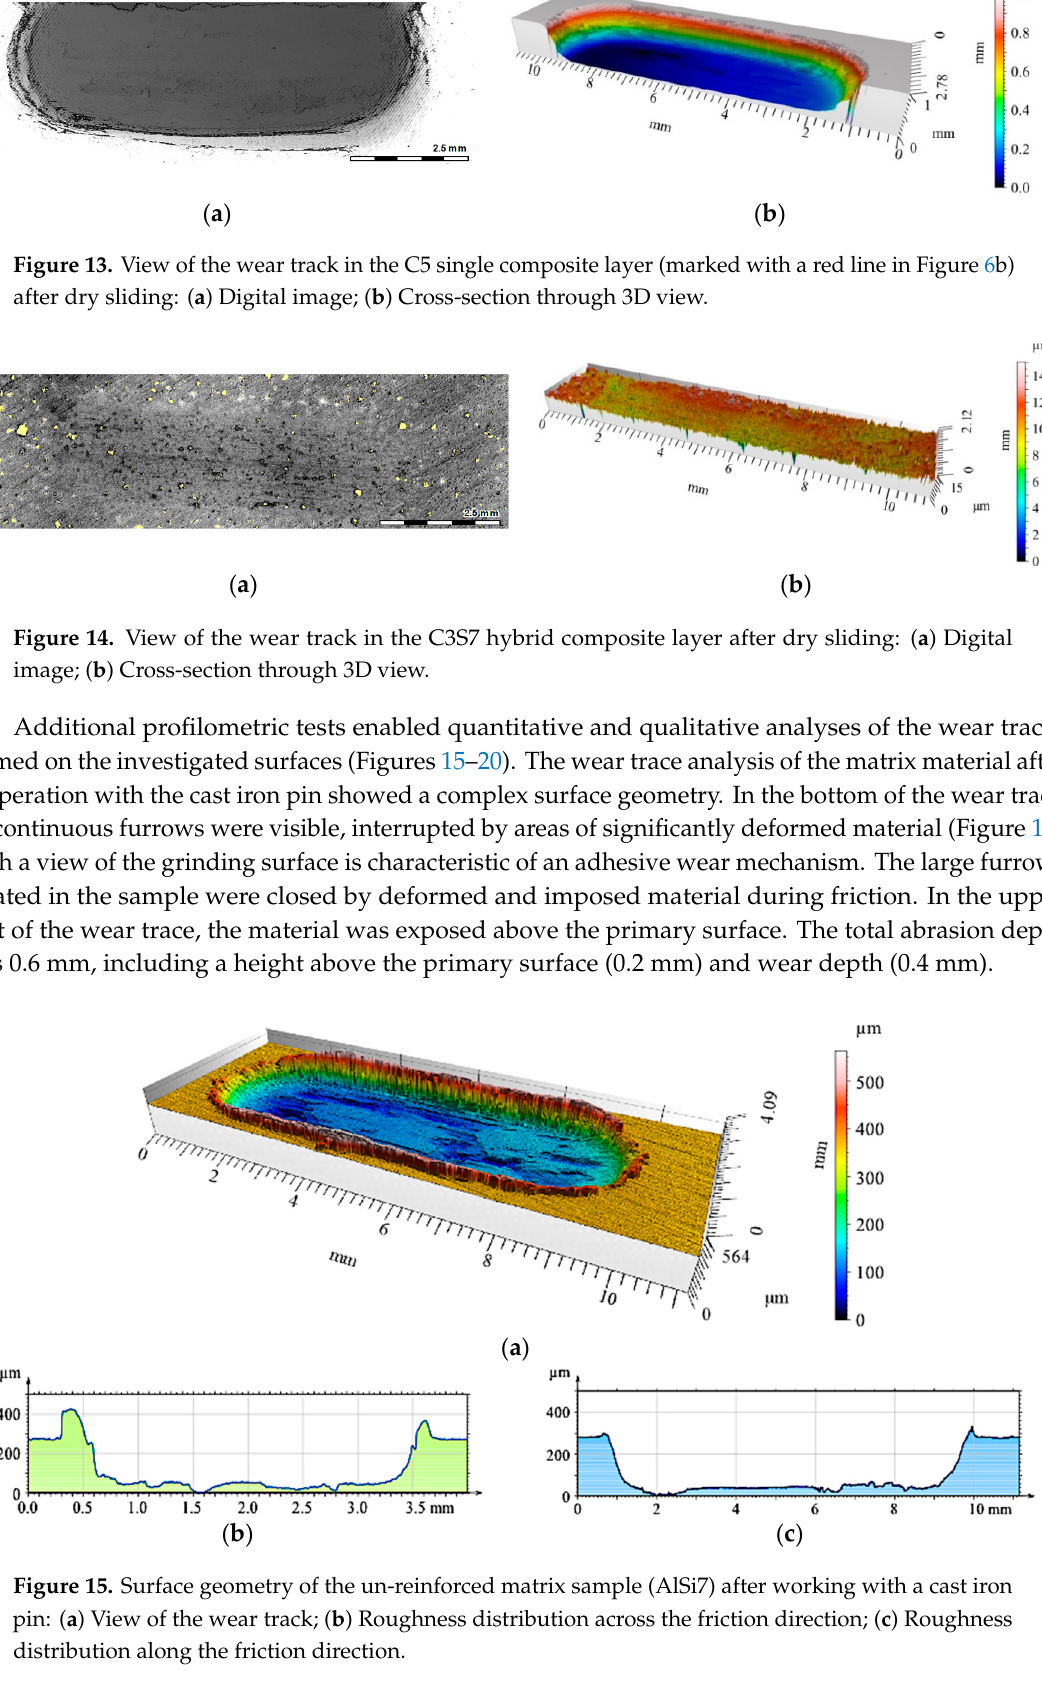
8 of 16 Figure 10. View of wear track in the S5 single composite layer (marked with a black line in Figure 8a) after dry sliding: ( a ) digital image; ( b ) cross-section through 3D view. ( a ) ( b ) Figure 11. View of wear track in the S10 single composite layer (marked with a gray line in Figure 8a) after dry sliding: ( a ) Digital image; ( b ) Cross-section through 3D view. ( a ) ( b ) Figure 12. View of wear track in the S15 single composite layer (marked with green line on Figure 8a) after dry sliding: ( a ) Digital image; ( b ) Cross-section through 3D view. Furthermore, increasing the reinforcing particle content affected the nature and distribution of visible scratches on the surface of the wear trace. In the case of the S5 sample, the scratches were clearly visible, much wider, and less regular compared with scratches formed on the S10 and S15 composite surfaces (Figures 11 and 12, respectively). Clear differences in the wear trace depth were recorded for the layers containing the carbon phases (Figures 13 and 14). For the sample marked C5, the depth of the trace was 0.8 mm (Figure 13b), which was the largest among all measured values in the tribological tests. In turn, the depth of